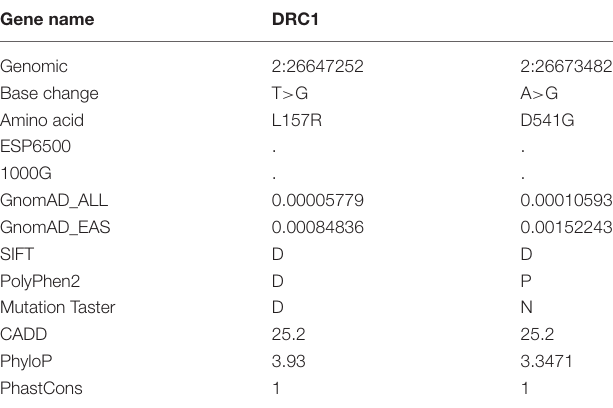
TABLE 1 | Compound heterozygous mutation in DRC1 gene was predicted in our patient by whole-exome sequencing